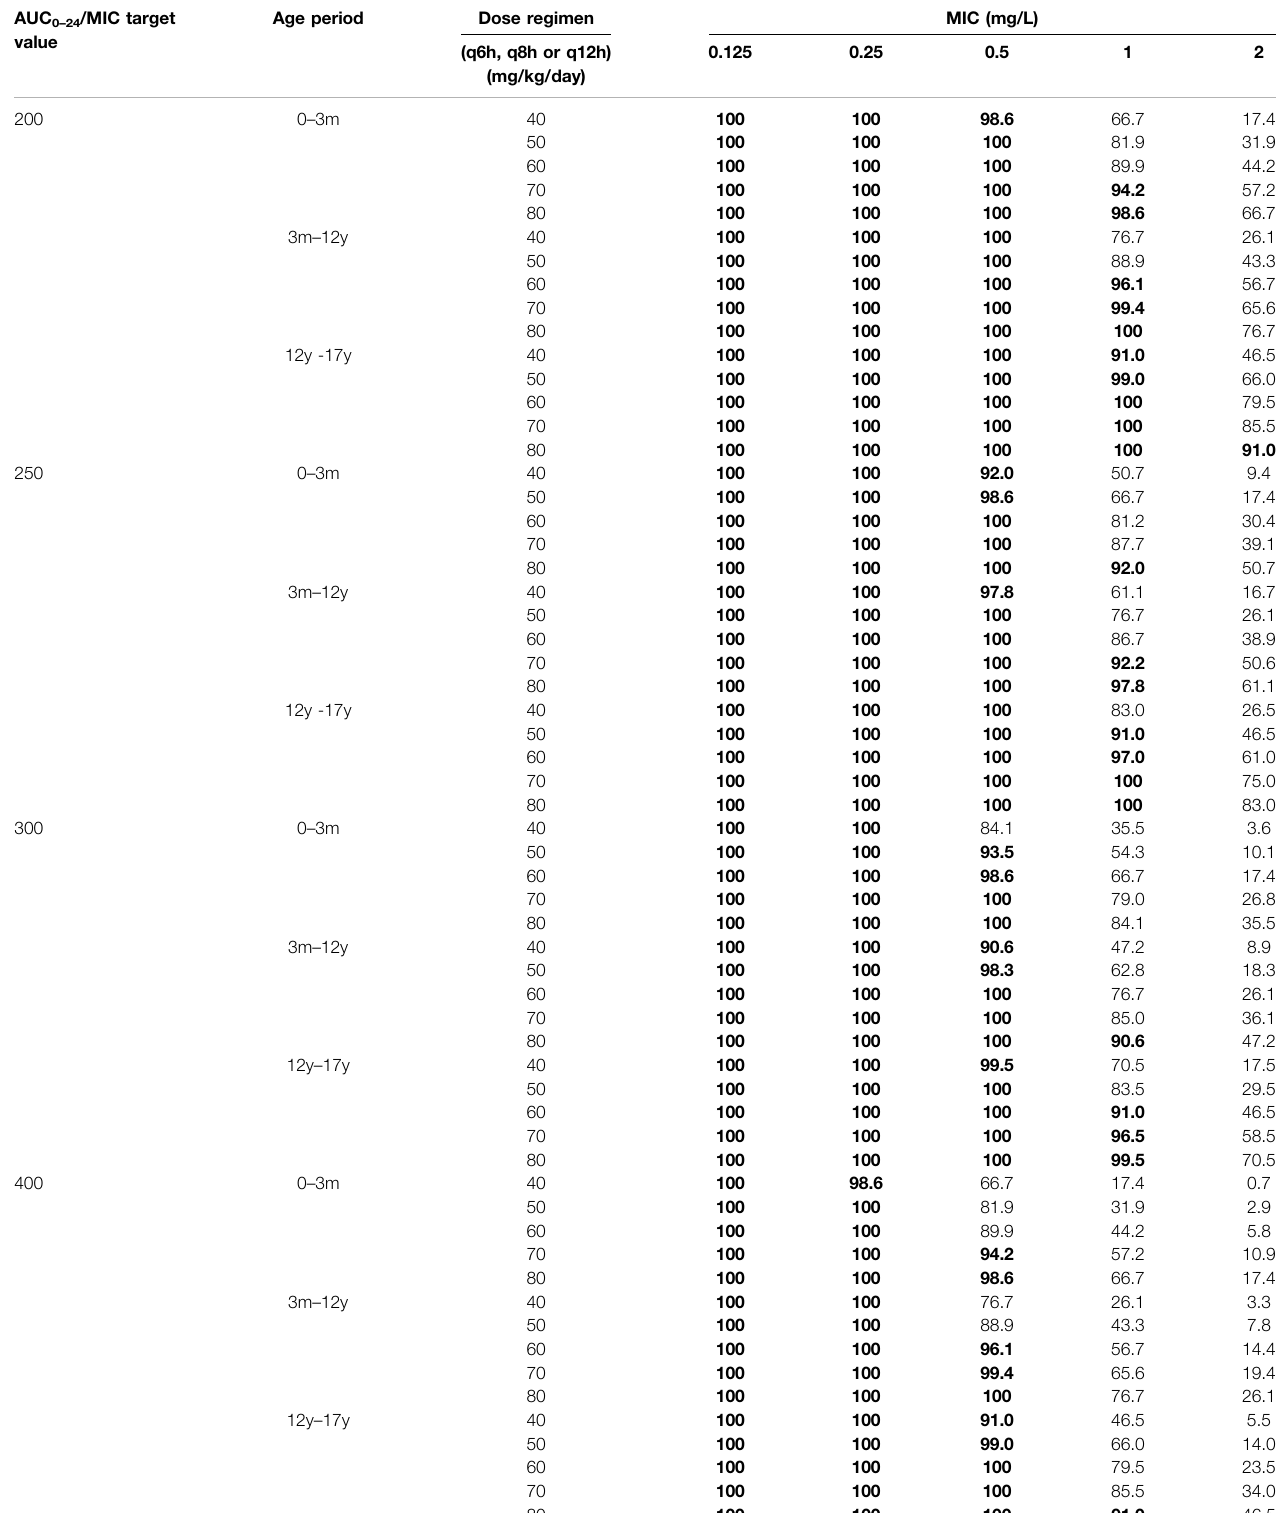
TABLE 6 | Population PK model predicted probability of target attainment (PTA) of vancomycin in pediatric patients at different ages under different dosing regimens and different target values. AUC 0 – 24 /MIC target